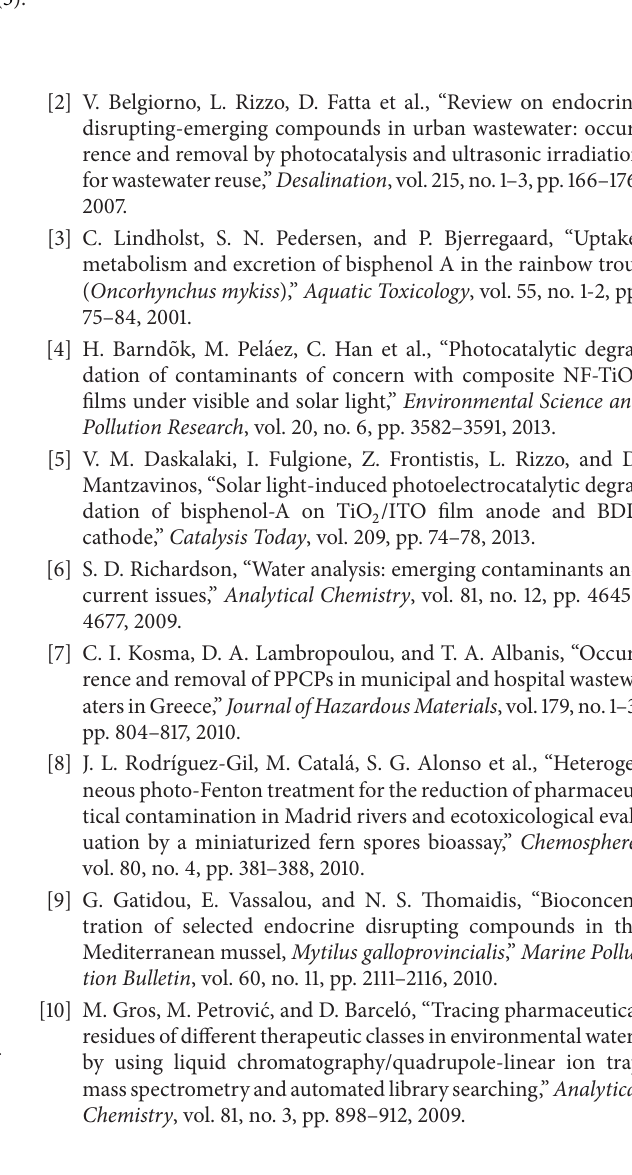
slope of the straight lines shown in inset Figure 10(a)) and decreases to 6 ± 1 10 −3 min −1 in WW (inset Figure